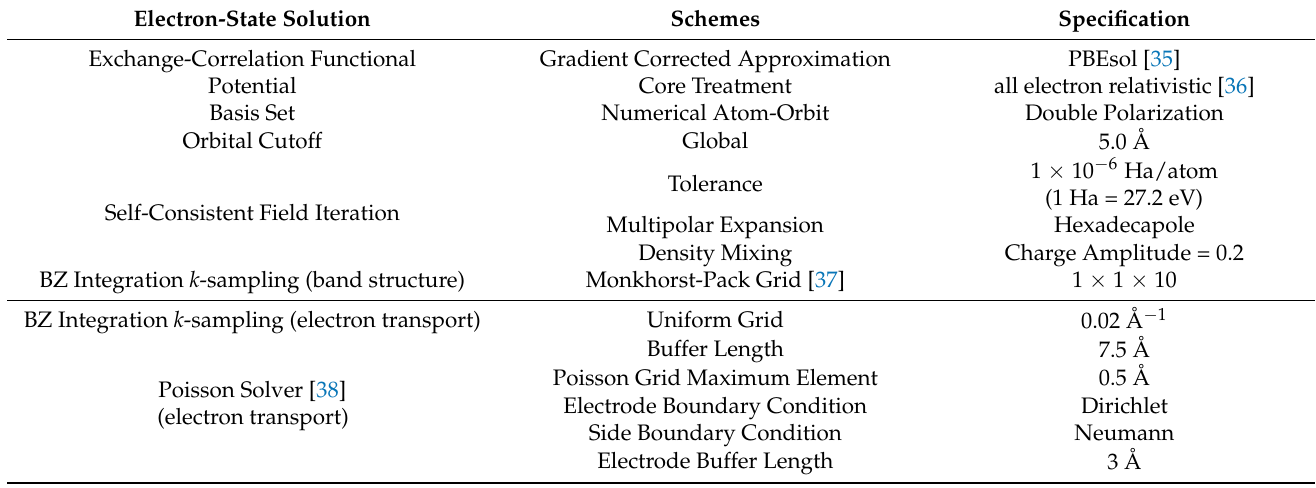
Table 1. Specifications in band structure and electron transport calculations with Dmol3